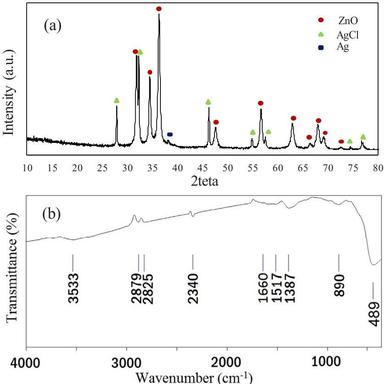
XRD pattern (a) and FTIR spectrum (b) of Ag/AgCl--ZnO nanocomposite.